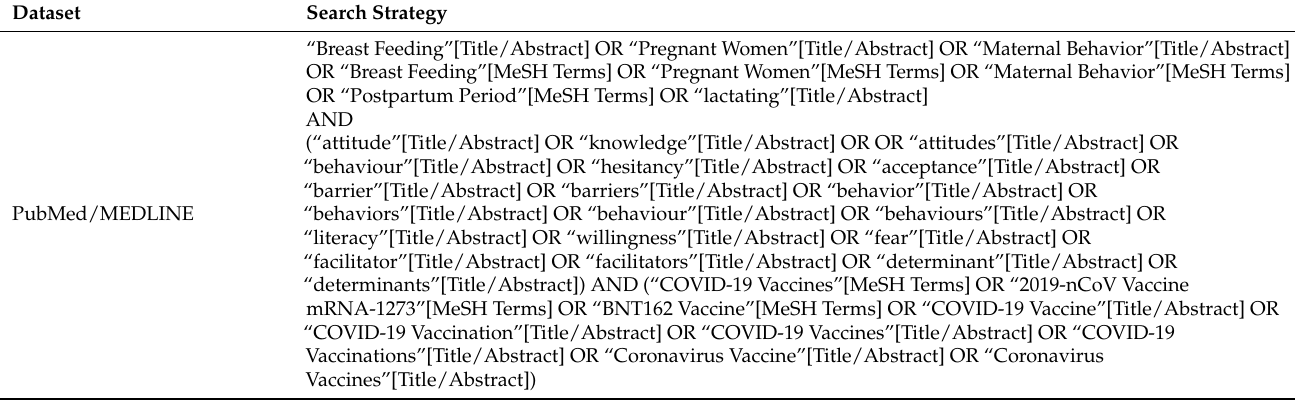
Table 1. Search strategy developed in